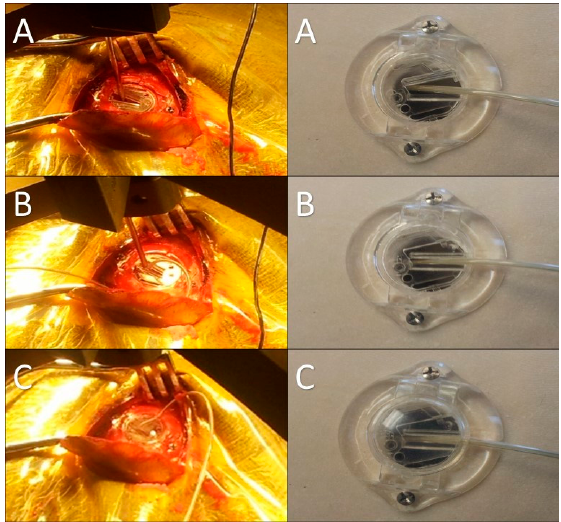
Figure 12. Intraoperative pictures and corresponding model images showing the steps of electrode fixation using the Stimloc device. ( A ) A special locking piece placed onto the Stimloc base with the electrode passing through it; ( B ) the electrode is locked in place with this piece after removing the stylet and moving the electrode out of the cannula; ( C ) the final step of the electrode fixation: the Stimloc cap is placed and fixed over its base.